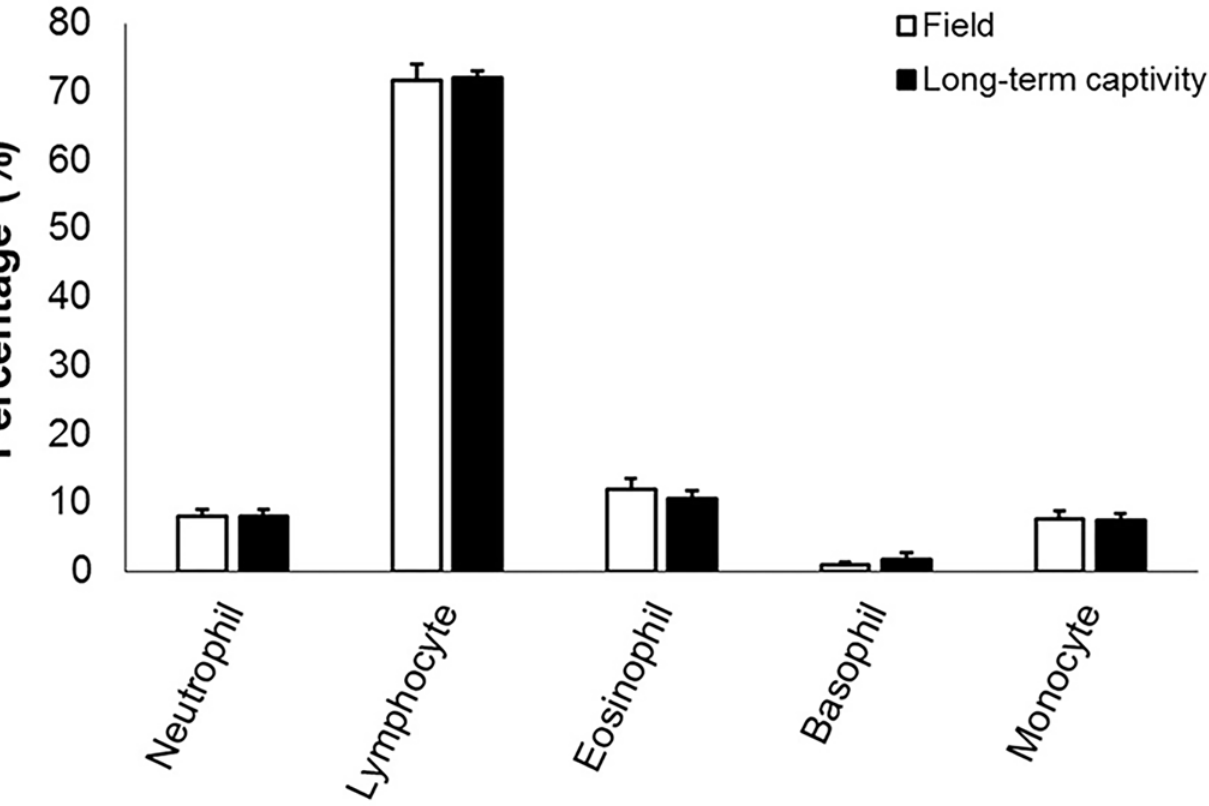
Fig 2. Leukocyte profile of Rhinella icterica . Leukocyte profile of adult males of Rhinella icterica under field conditions and after long-term captivity (three months). Bars represent mean ± standard error. N is the same for all variables ( N =